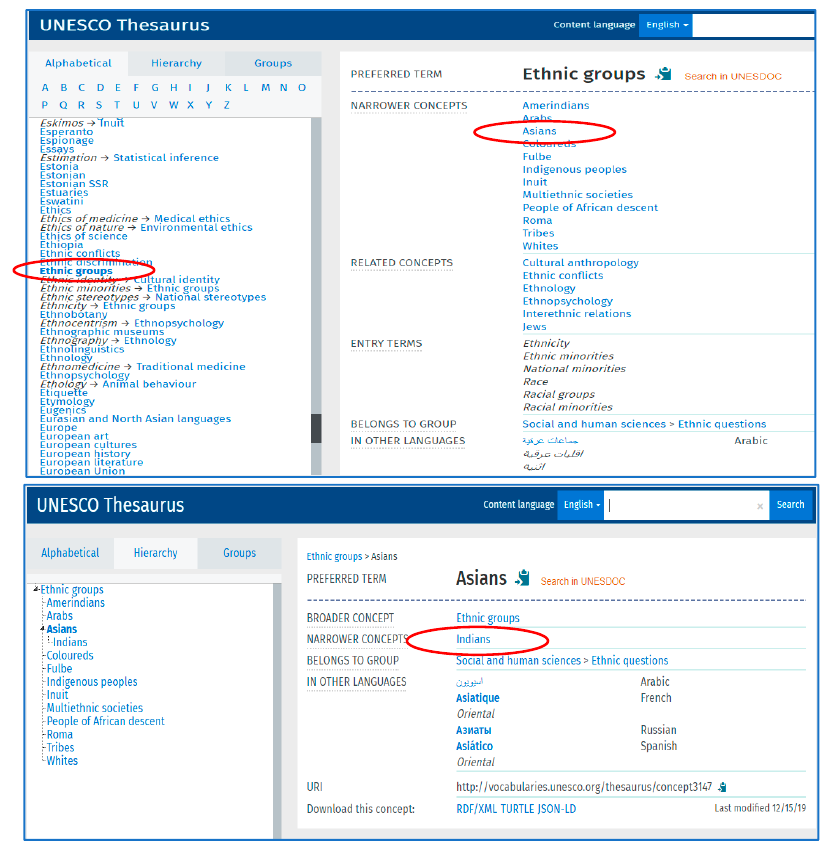
Figure 9. Screen shot of The UNESCO Thesaurus from http://vocabularies.unesco.org/browser/thesaurus/en/index/E accessed on 14 July 2021.